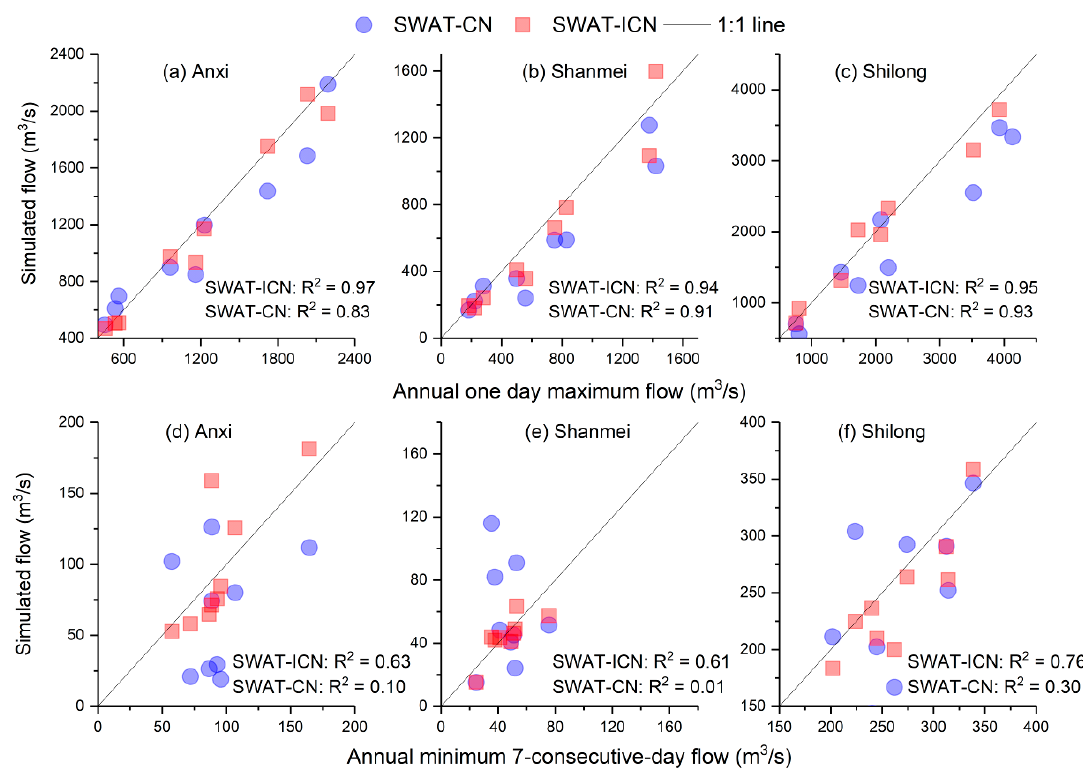
Figure 7. Annual one day maximum flow (1-DMF) of SWAT-ICN versus SWAT-CN for Anxi ( a ), Shanmei ( b ), and Shilong ( c ) gauge stations, and seven consecutive days’ minimum flow (7-CDMF) of SWAT-ICN versus SWAT-CN for Anxi ( d ), Shanmei ( e ), and Shilong ( f ) gauge stations.